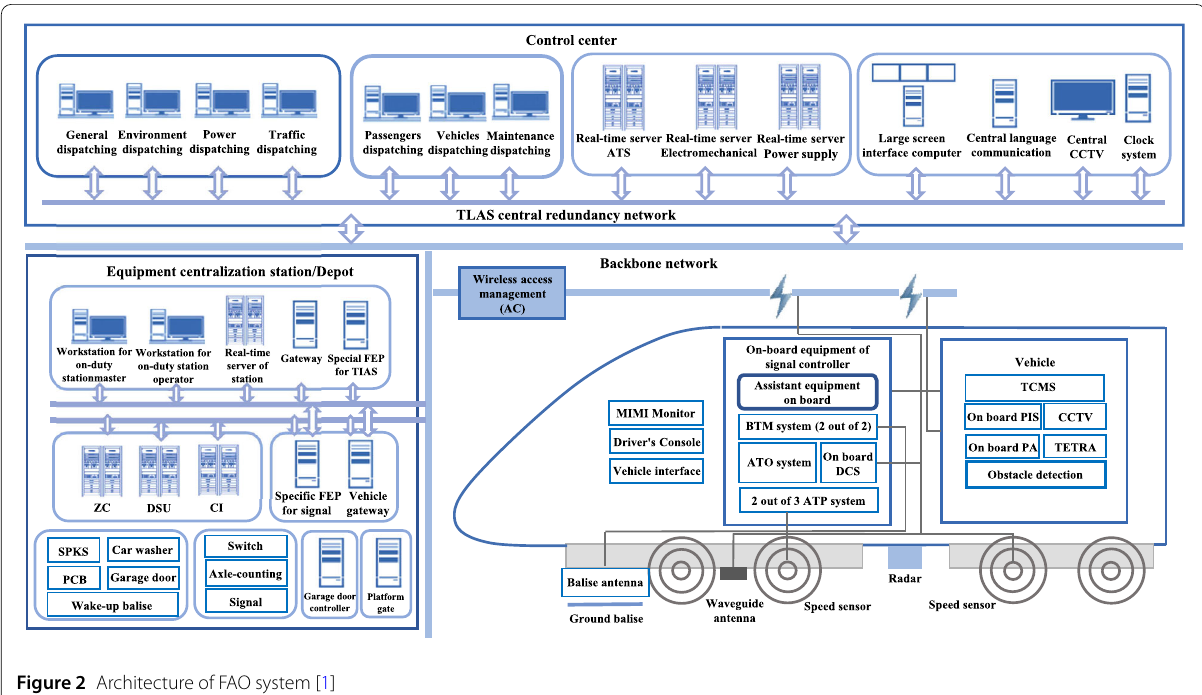
Figure 2 Architecture of FAO system